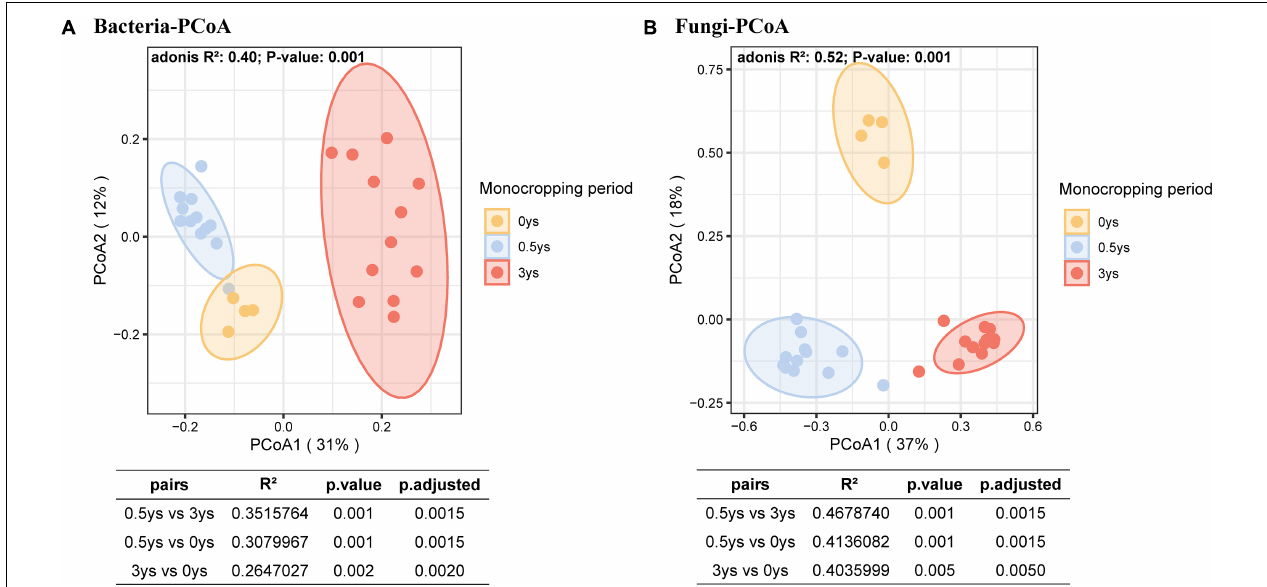
FIGURE 5 | Difference of the rhizosphere microbial community profiles of various monoculture years. Points’ color represents different monoculture periods. The points are covered by a 95% confidence ellipse. Pairwise PERMANOVA is shown below the PCoA plots. (A) PCoA of prokaryotic communities. (B) PCoA of fungal